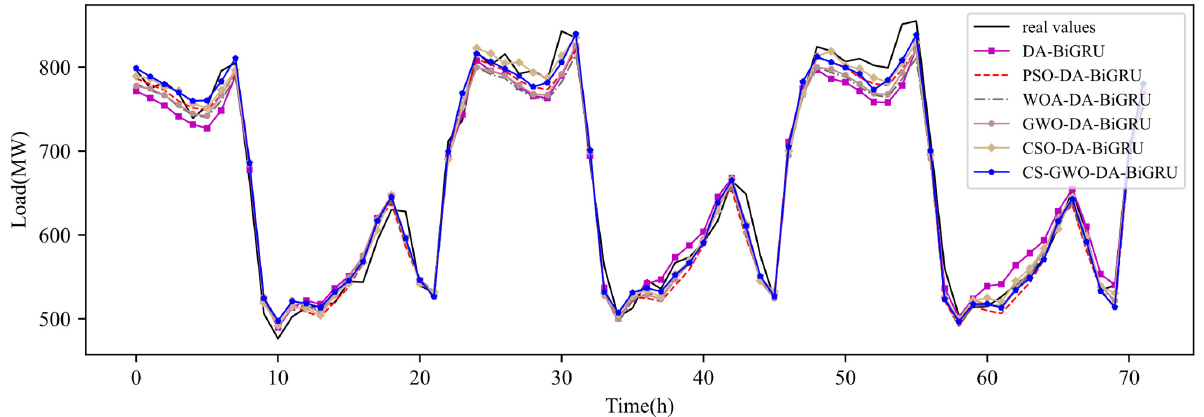
Figure 8. Case study 2: comparison of forecasting results on 29–31 December 2018.